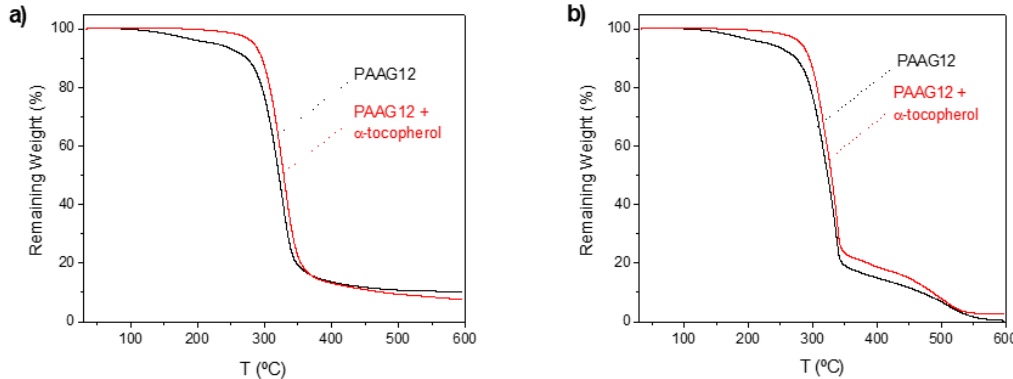
Figure 3. Thermogravimetric Analysis (TGA) of the PAAG-12 control film and the film charged with 5% α -tocopherol in ( a ) nitrogen and ( b ) air atmospheres.